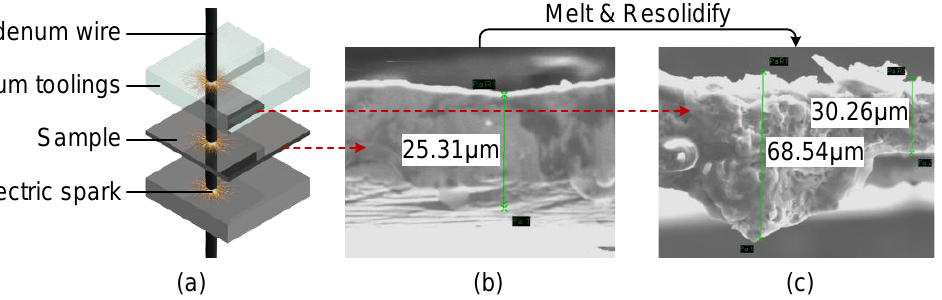
Figure 4. Section morphology results of samples before and after W-EDM. ( a ) Schematic diagram of sample in W-EDM. ( b ) Section morphology of the original ribbon. ( c ) Section morphology of the sample after